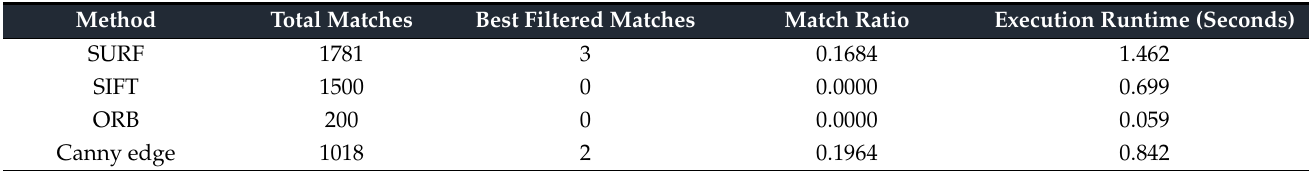
Table 2. Quantitative comparison and computational costs and time of the different feature detector descriptors for baseline analysis (Ahuna Mons vs. Equator Crater).